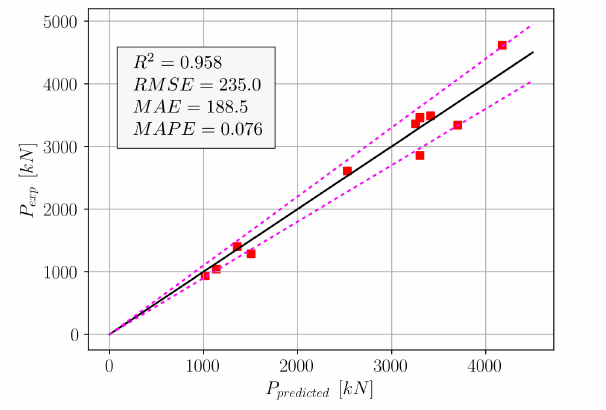
Figure 8. Comparison of experimental and predicted (Equation (19)) p values.